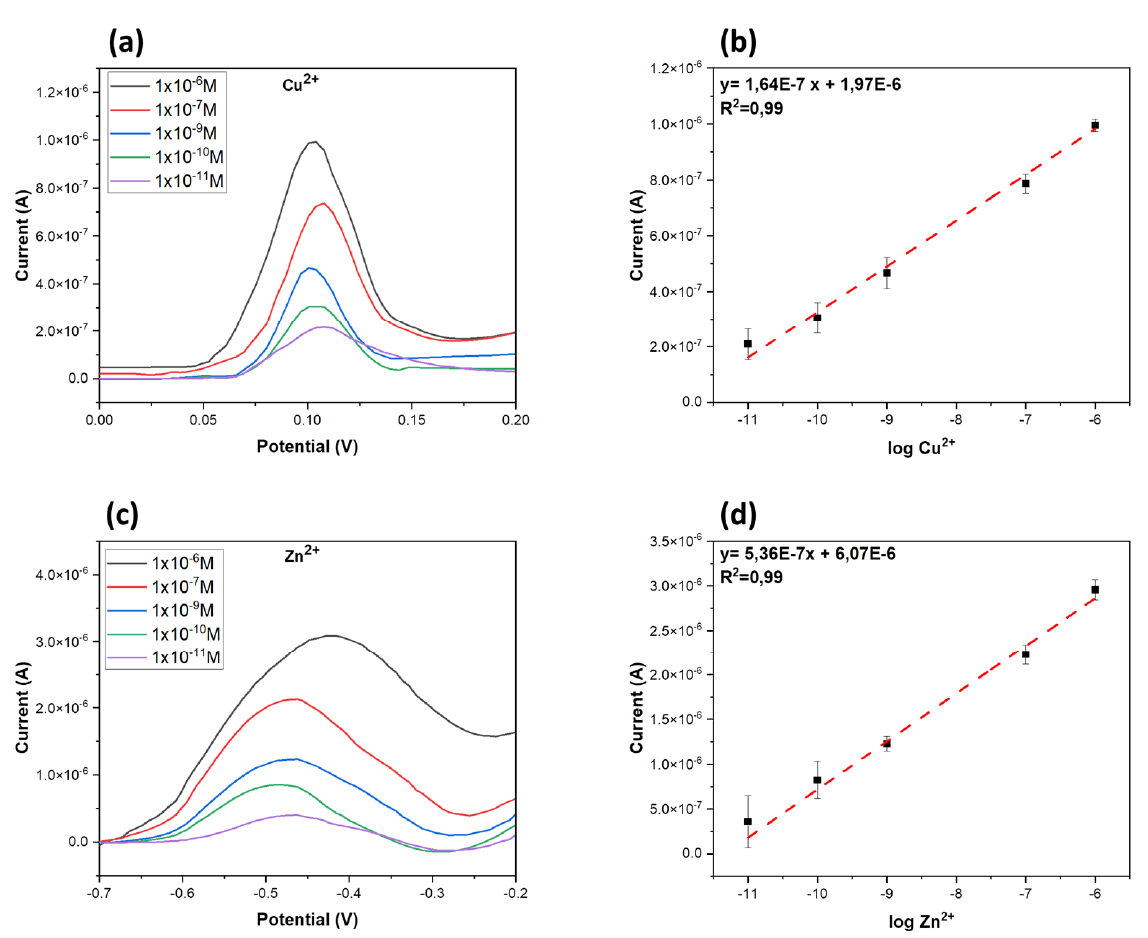
Figure 5. Electrochemical characterization of ion sensors. Square wave voltammograms of Cu 2+ at different concentrations (1 × 10 − 11 , 1 × 10 − 10 , 1 × 10 − 9 , 1 × 10 − 7 , 1 × 10 − 6 M) in PBS ( a ); plot of CuCl 2 peak currents vs. log Cu 2+ concentrations ( b ). Square wave voltammograms of Zn 2+ at different concentrations (1 × 10 − 11 , 1 × 10 − 10 , 1 × 10 − 9 , 1 × 10 − 7 , 1 × 10 − 6 M) in PBS ( c ); plot of ZnCl 2 peak currents vs. log Zn 2+ concentrations ( d ).